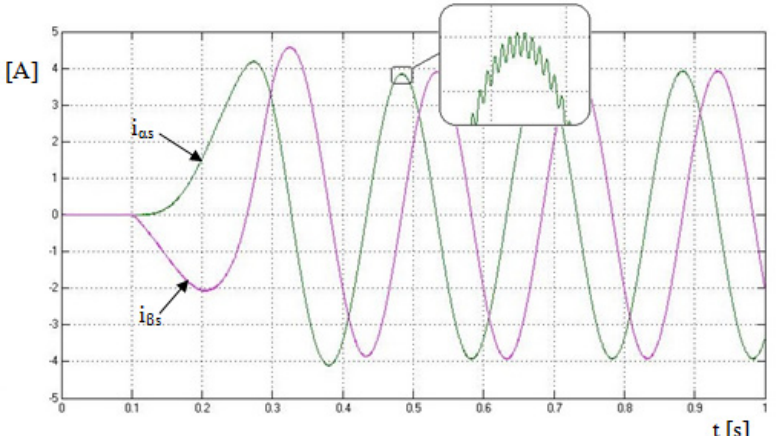
Figure 8. ASM stator currents in αβ with detail on the response of the HF signal.